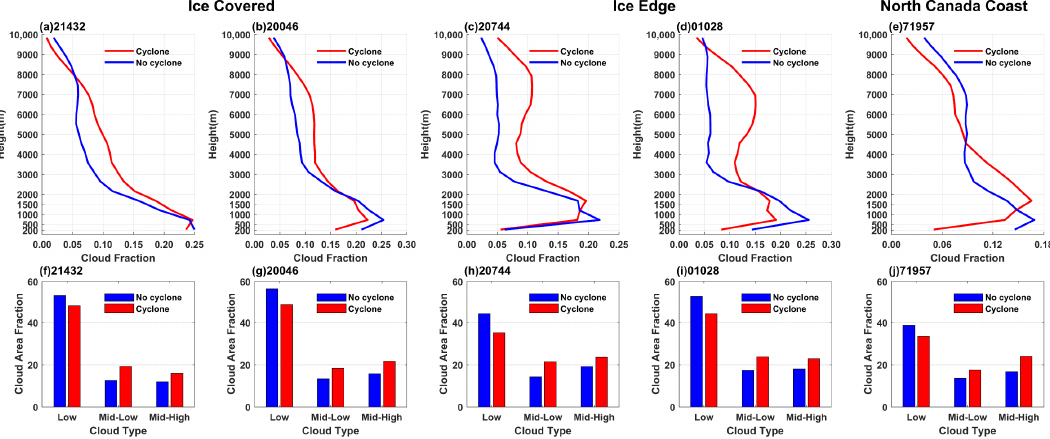
Figure 7. Composite vertical profiles of the cloud fraction on the cyclone days (red line) and no-cyclone days (blue line) based on the GOCCP data ( a – e ), and composite daily low, mid-low, and mid-high cloud fractions on the cyclone days (red column) and no-cyclone days (blue column) based on the CERES data ( f – j ) at the five sounding stations (the station number is labeled above each figure). The cloud fraction at each station is the mean value of the data at the four grid points surrounding the location of each sounding station.